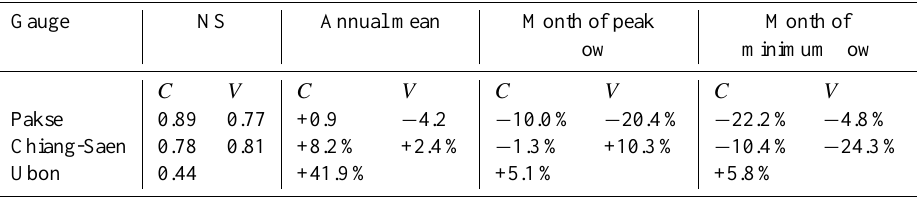
Table 1. Nash Sutcliffe (NS) values and percent difference between modelled and observed (modelled minus observed) for the three calibra- tion points in the Mekong Basin during the calibration ( C ) and validation ( V ) periods. (Validation period values for Ubon are not given as data for Ubon ends in